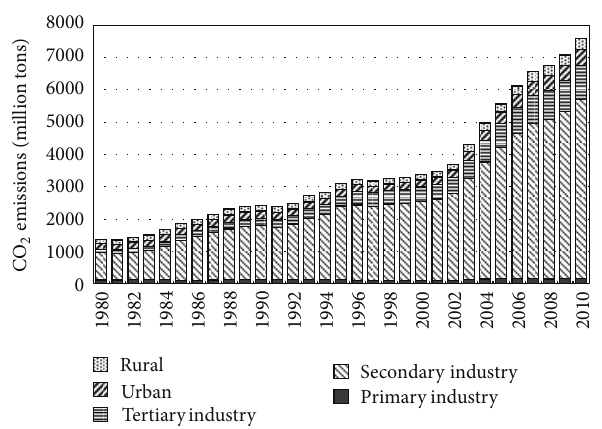
Figure 1: CO 2 emissions of industrial and residential consumption sectors